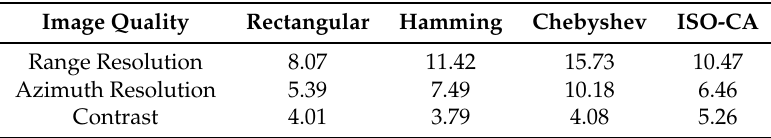
Table 3. Image Quality